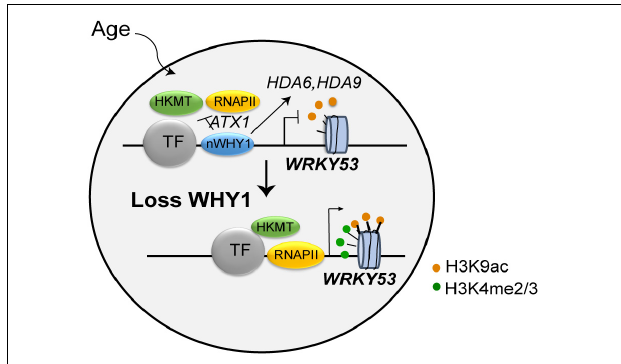
FIGURE 7 | Working model of WHIRLY1 regulates WRKY53 transcription. WHIRLY1 binding on WRKY53 promoter represses enrichment of H3K4 methylation by ATX1 inhibiting the PIC formation in leaf senescence initiation and modulates the enrichment of H3K9ac by association with HDACs and high-level transcription at early senescence stage. In absence of WHIRLY1, other transcription activators recruit histone lysine methyltransferase and HDACs is dissociated from WRKY53 resulting in elevated H3K4me3, H3K9ac levels, and higher occupancy of RNAPII in WRKY53 loci, thus increasing the transcription of WRKY53 . TF, transcription factor; HDACs, histone deacetylases; RNAPII, RNA polymerase II; HKMT, histone lysine methyltransferase; nWHY1, nuclear WHY1